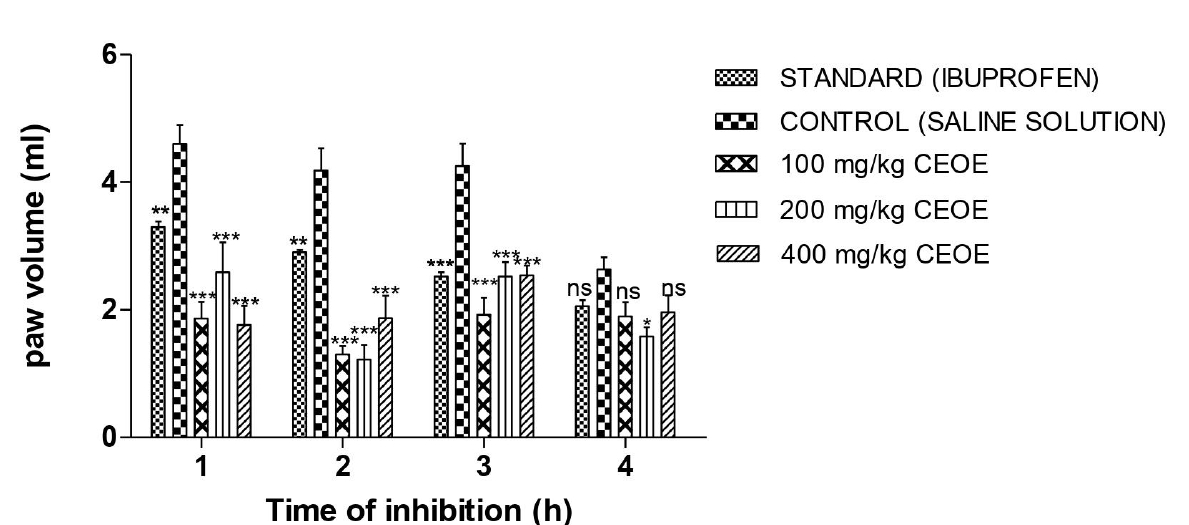
FIGURE 2 - Effect of C. equisetifolia on Carrageenan-induced inflammation. Control, Standard, and CEOE represent 1 mL saline solution, 100 mg/kg of Ibuprofen injection and 100, 200 and 400 mg/kg of essential oils of C. equisetifolia respectively. * p <0.05, ** p <0.01, *** p <0.001 statistically compared to